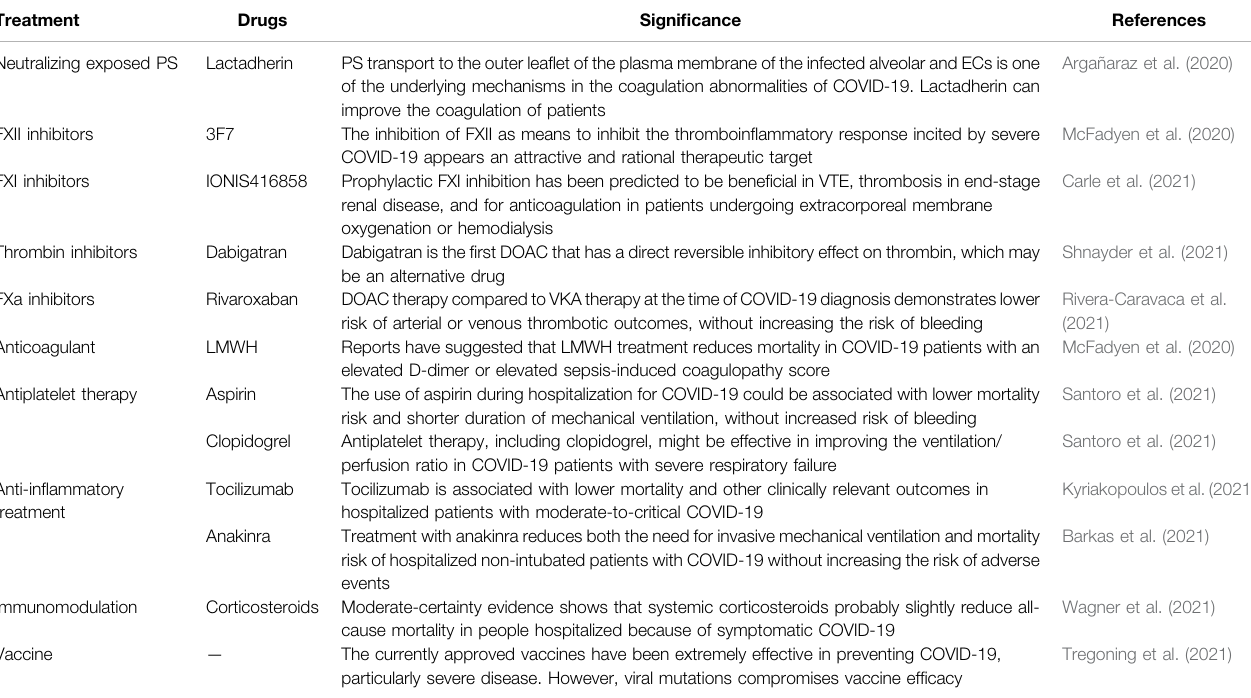
TABLE 1 | Treatment strategies for COVID-19 patients with